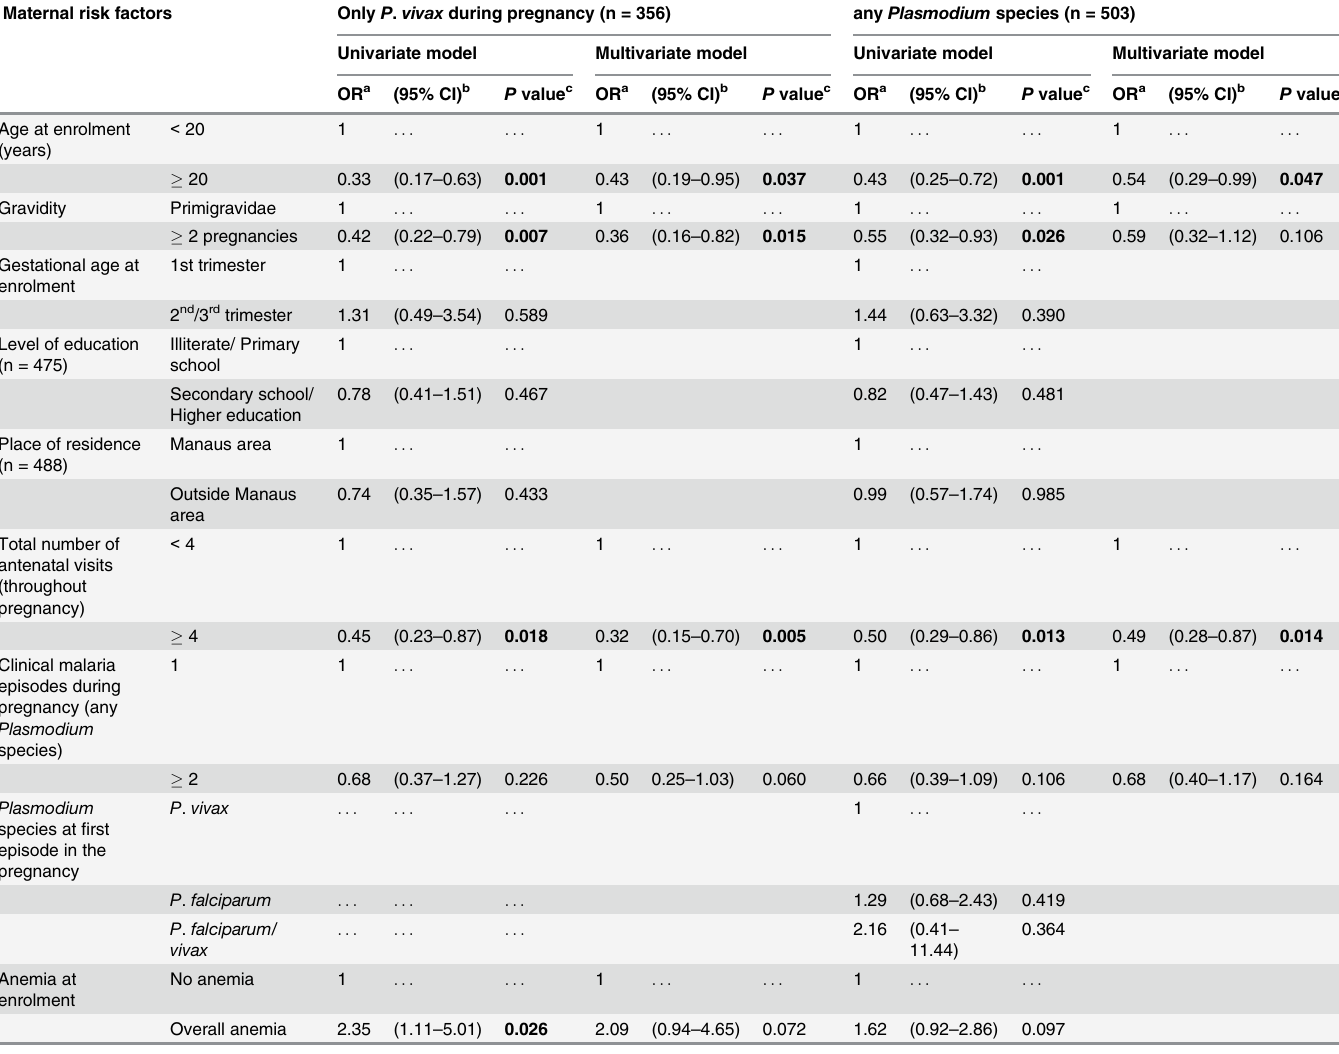
Table 3. Risk factors for premature delivery among study pregnant women with malaria. Maternal risk